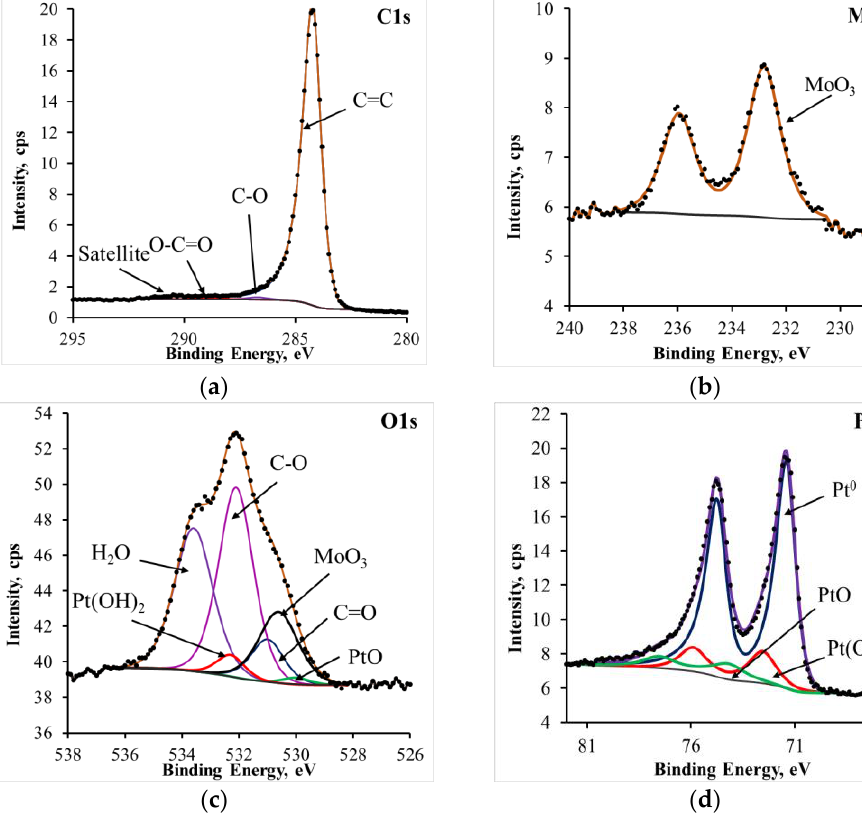
Figure 2. C1s ( a ), Mo3d ( b ), O1s ( c ), and Pt4f ( d ) X-ray spectra recorded on PtMo/CNT NaOH .